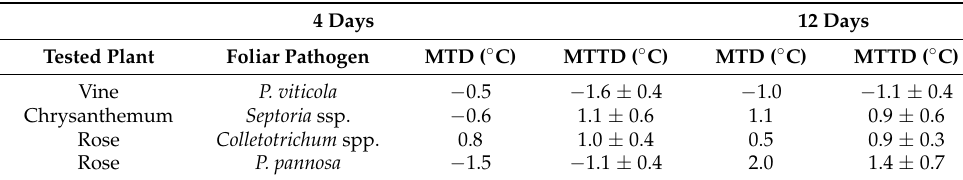
Table 1. The maximum temperature difference (MTD) between infected and uninfected leaves and the mean temperature tissue difference (MTTD) between infected and uninfected tissue leaf on the same leaf. Negative numbers indicate that infected leaves or tissues had a lower temperature then the uninfected